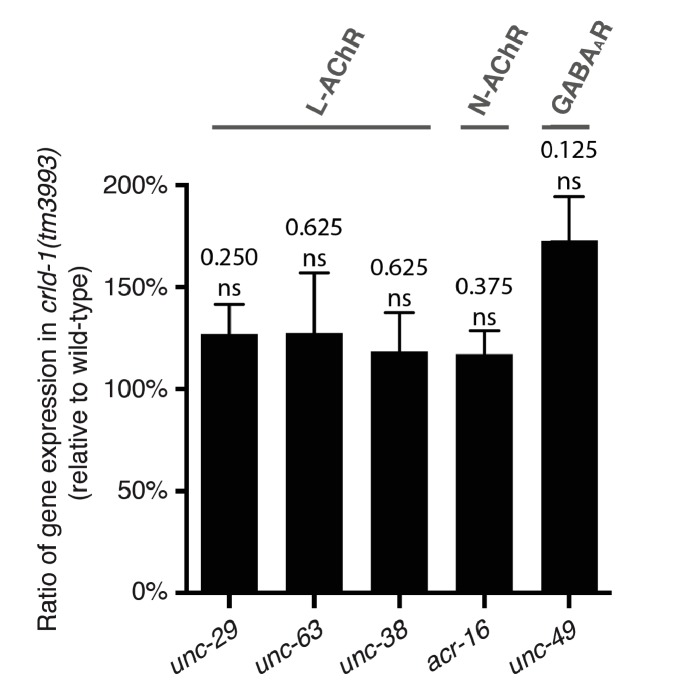
– Measurement of L-AChR subunit mRNA levels.Transcript levels of ionotropic receptor subunits are not significantly decreased in crld-1(tm3993). Quantitative real-time PCR measurements of mRNA levels for heteromeric levamisole-sensitive AChRs (L-AChR; unc-29, unc-63, and unc-38), homomeric nicotine-sensitive AChRs (N-AChR; acr-16), and GABAA receptors (unc-49). mRNA samples were collected from synchronized L4 larvae. Fold-change, mean ± SEM in crld-1(tm3993) relative to WT is shown in four independent experiments. P values are indicated on the figure, ns (not significant), after Bonferroni Holm correction, Wilcoxon signed-rank test.